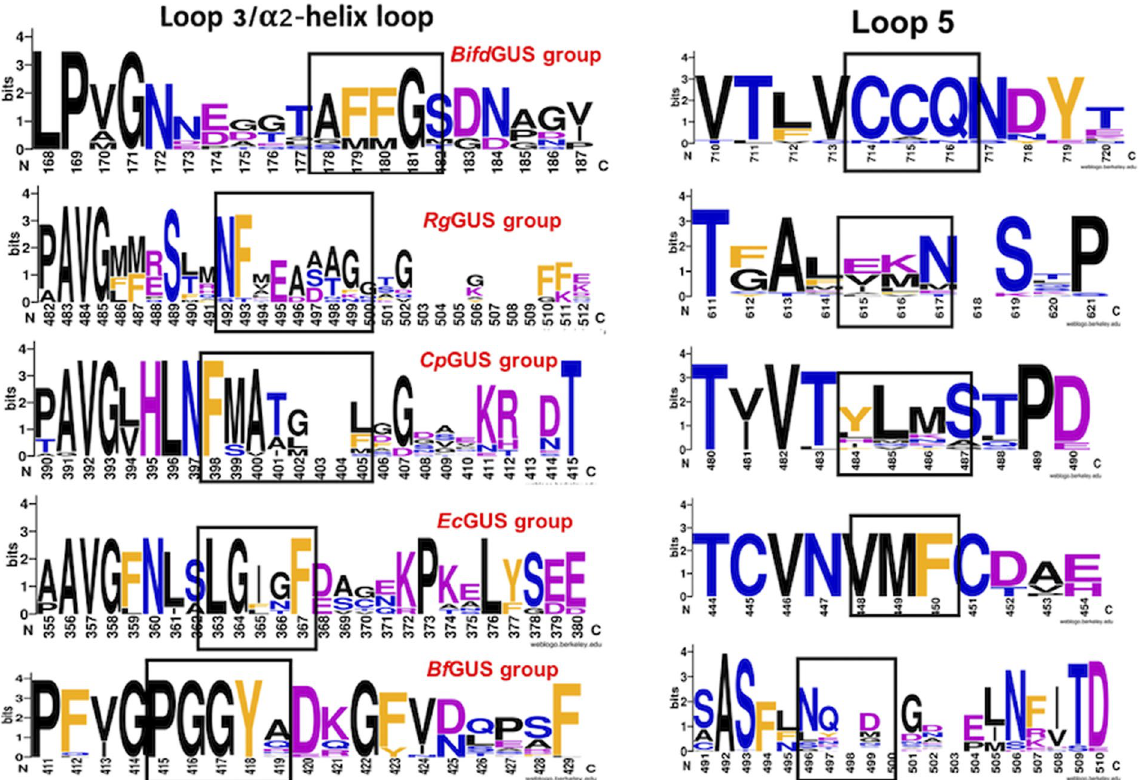
Figure 6. Structure-guided sequence analysis of the ABSs suggests a functional classification for gut bacterial GUSs. Relative occurrence of residues in loop 3 (or in the α 2-helix loop) and loop 5 of the bacterial GUSs. Each of the five enzymes studied for this report was used as a query for an NCBI BLASTp search. After downloading the sequences sharing 55 to 95% identity, proteins derived from environmental or industrial sample were manually removed. The remaining enzymes were aligned in the T-Coffee-Expresso server, and a sequence logo for each group was created using WebLogo. The residues forming the ABS of each groups of GUSs are highlighted in black rectangles. The physicochemical properties of the side chains of the residues are shown in black (nonpolar, aliphatic residues), orange (aromatic), blue (polar, uncharged), and purple (polar,